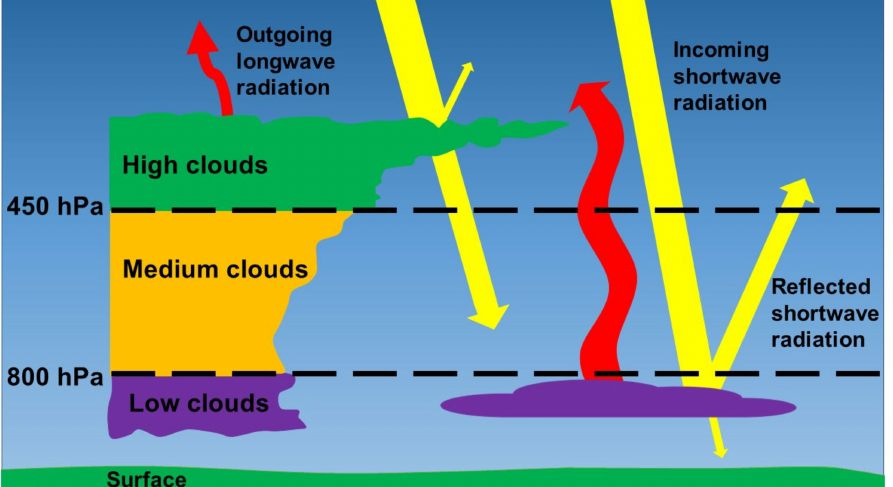
Figure 1. Schematic diagram of the radiative effect of clouds at different